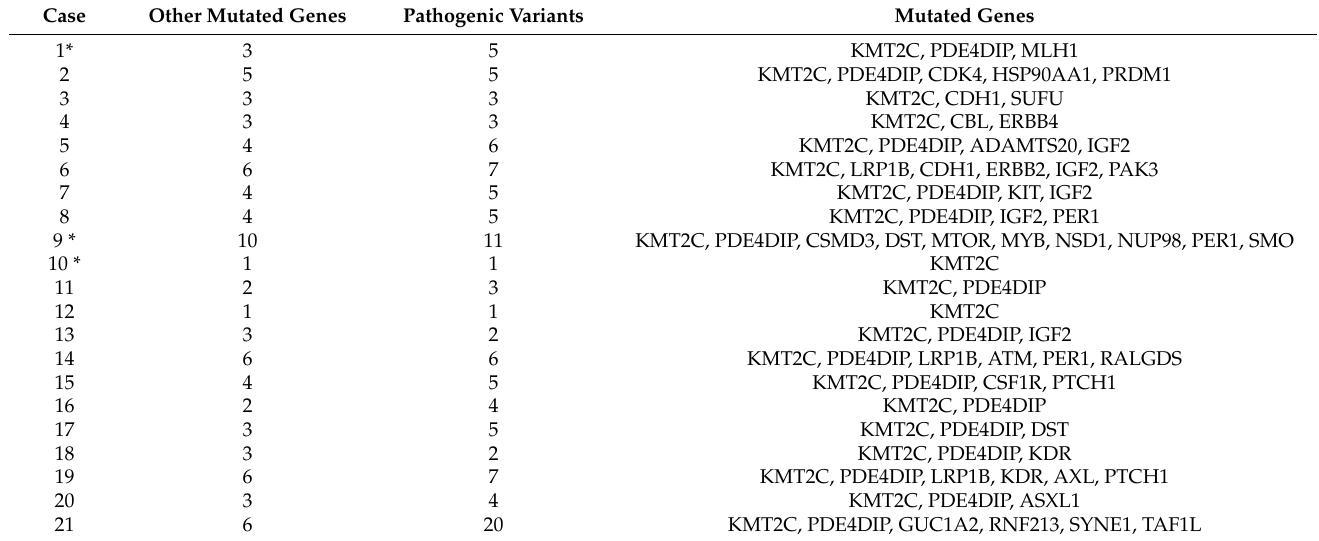
Table 3. Further pathogenic mutations detected in 21 atypical DPNs.